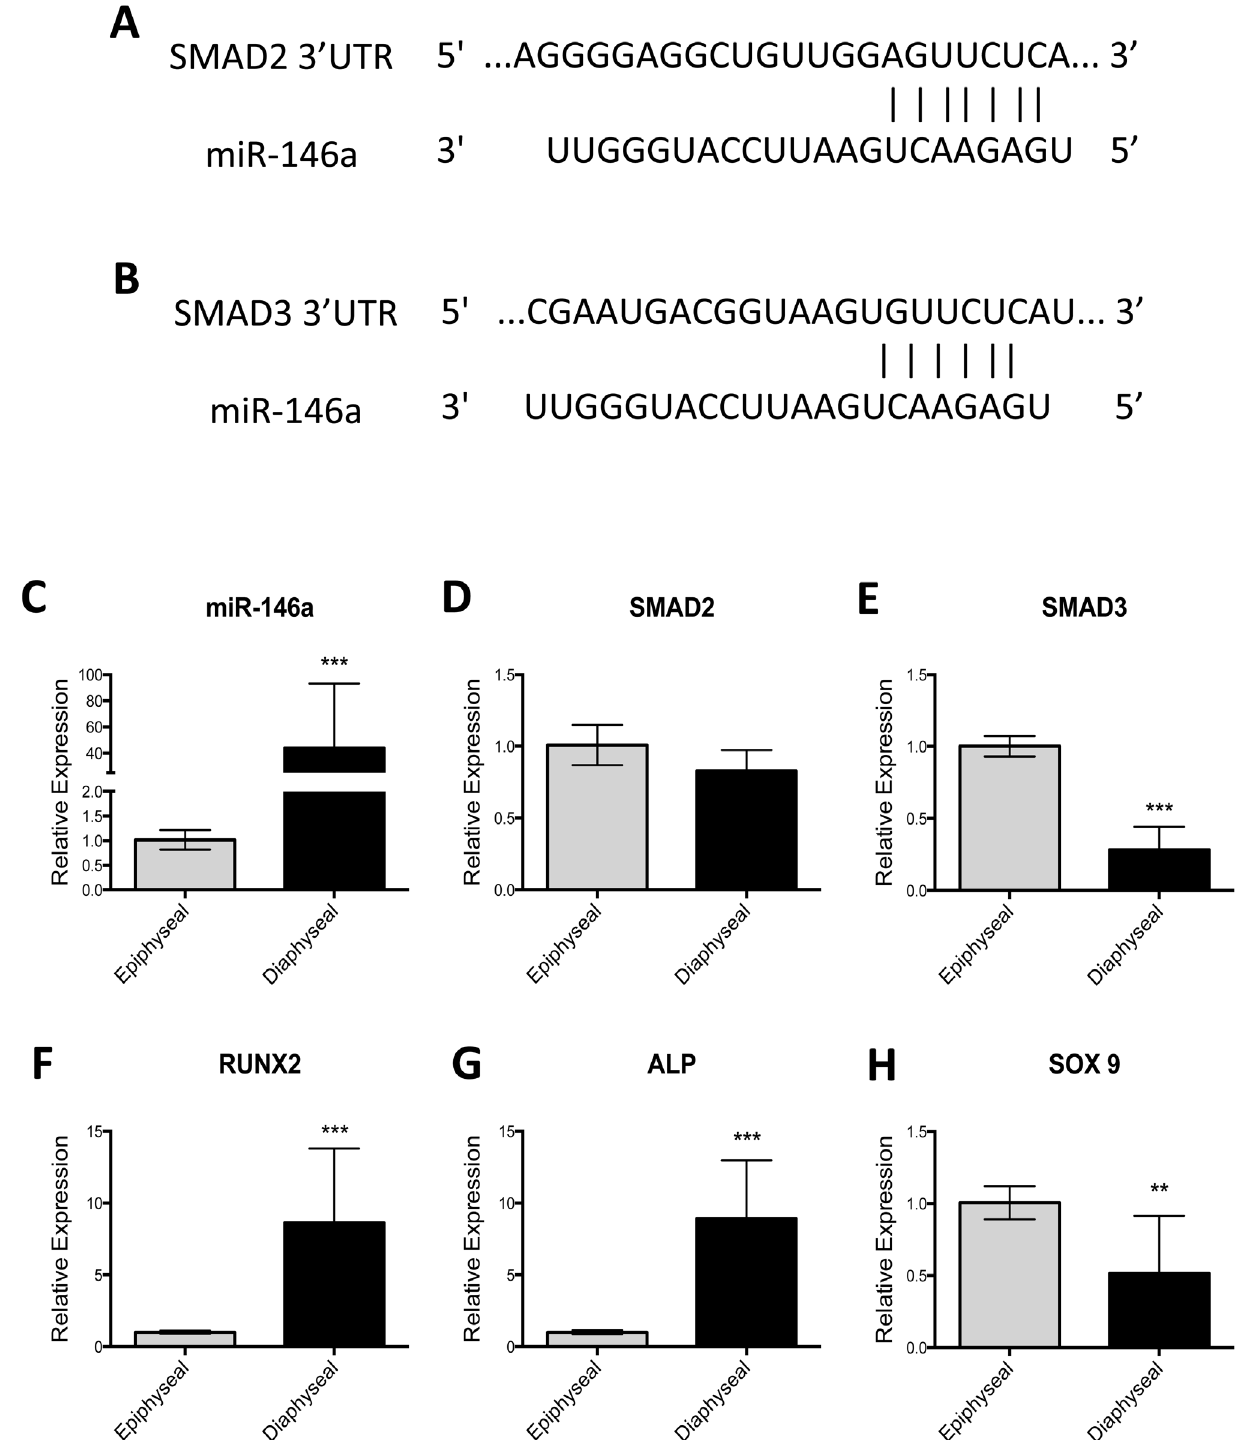
Figure 6. Predicted binding site for miR-146a in SMAD2 and SMAD3 mRNA 3 9 UTR and the relationship between expression of miR- 146a, SMAD2, SMAD3 and Type X Collagen expression in epiphyseal and diaphyseal cell populations. SMAD2 and SMAD3 mRNA 3 9 UTR contains a binding site for miR predicted by TargetScan (A–B). Increased expression of miR-146a in diaphyseal cell populations was correlated with reduced expression in SMAD3 mRNA levels but not SMAD2 mRNA levels (D–E). Increased expression of miR-146a in diaphyseal cells was coupled with an increase in expression of RUNX2 and ALP (F–G). Reduced expression of SOX9 was observed when miR-146a was highly expressed. Relative expression was normalized to MAMM-U6 (C) and b -Actin (D–H). Data represents an average of three independent patient samples and error bars represent standard deviation. * P , 0.05, ** P , 0.01; *** P , 0.001 calculated using Mann-Whitney test.